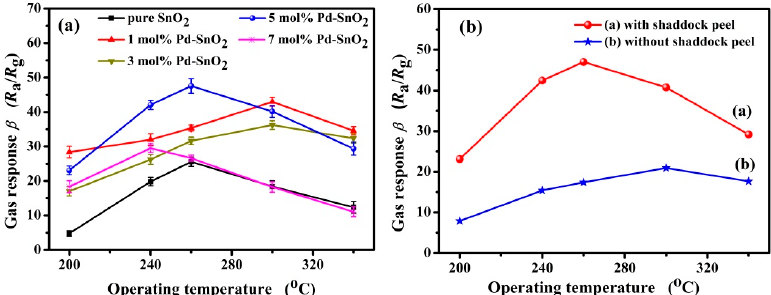
Figure 4. ( a ) Gas response as a function of temperature toward 3000 ppm butane of sensors prepared from SnO 2 , functionalized with different amounts of Pd; and ( b ) temperature dependence of gas